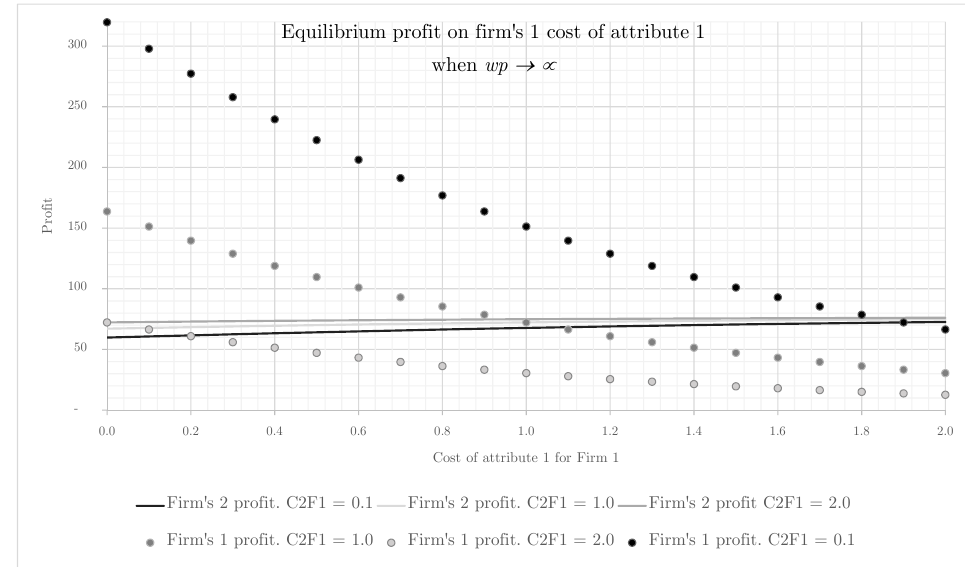
Figure A6. Firms’ profit share varying attributes’ cost of Firm 1 when wp (cid:29) 0.